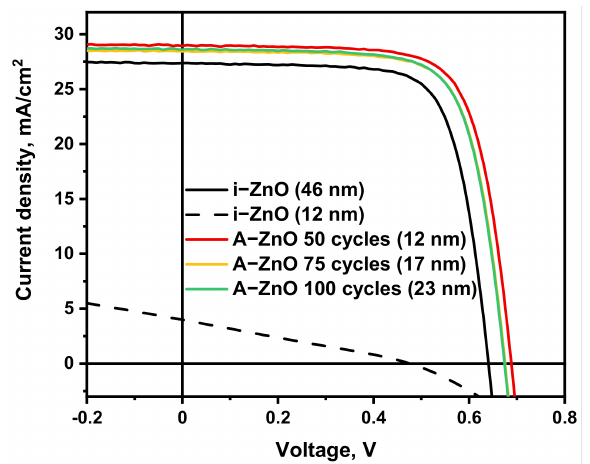
Figure 4. Characteristic current-voltage curves of CIGS solar cells with sputtered i-ZnO and A-ZnO window layers with different